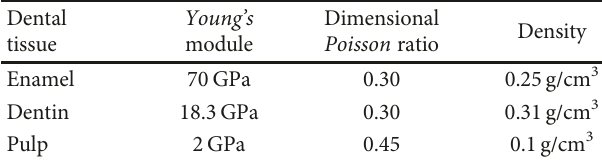
Table 1: Mechanical properties used in the analysis.